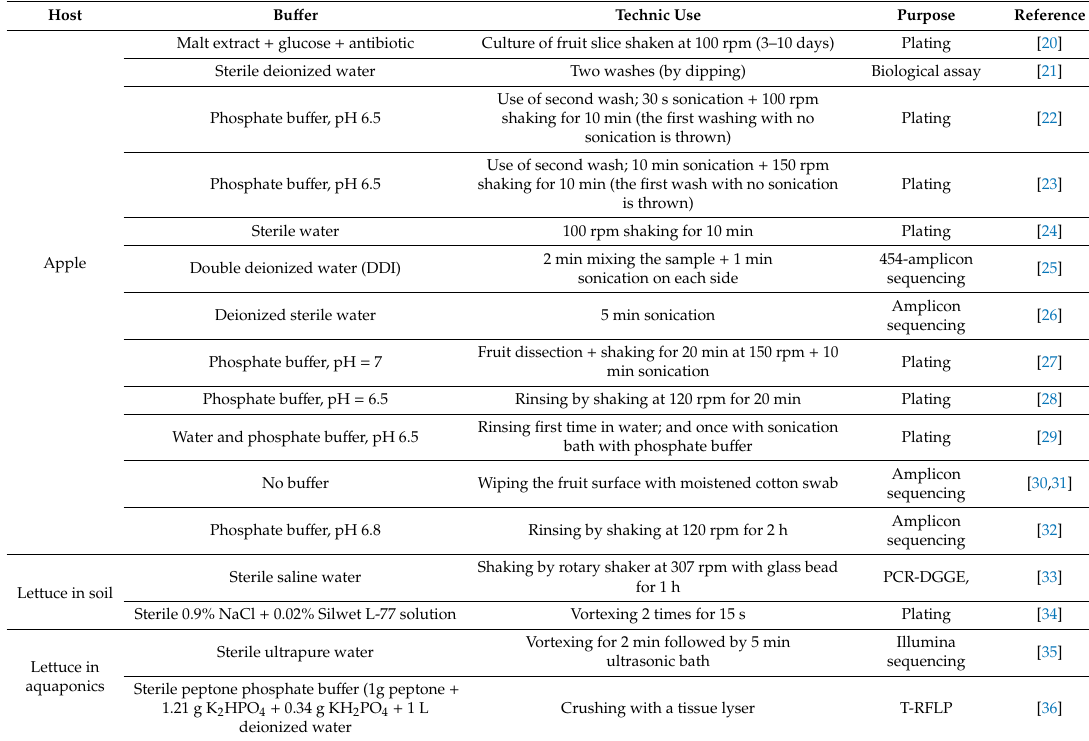
Table 1. Diversity of protocol for harvesting microbiomes from apple carposphere and lettuce roots. Host Bu ff er Technic Use Purpose Reference Malt extract + glucose + antibiotic Culture of fruit slice shaken at 100 rpm (3–10 days) Plating [20] Sterile deionized water Two washes (by dipping) Biological assay [21] Use of second wash; 30 s sonication + 100 rpm Phosphate bu ff er, pH 6.5 shaking for 10 min (the first washing with no Plating [22] sonication is thrown) Use of second wash; 10 min sonication + 150 rpm Phosphate bu ff er, pH 6.5 shaking for 10 min (the first wash with no sonication Plating is thrown) Sterile water Apple